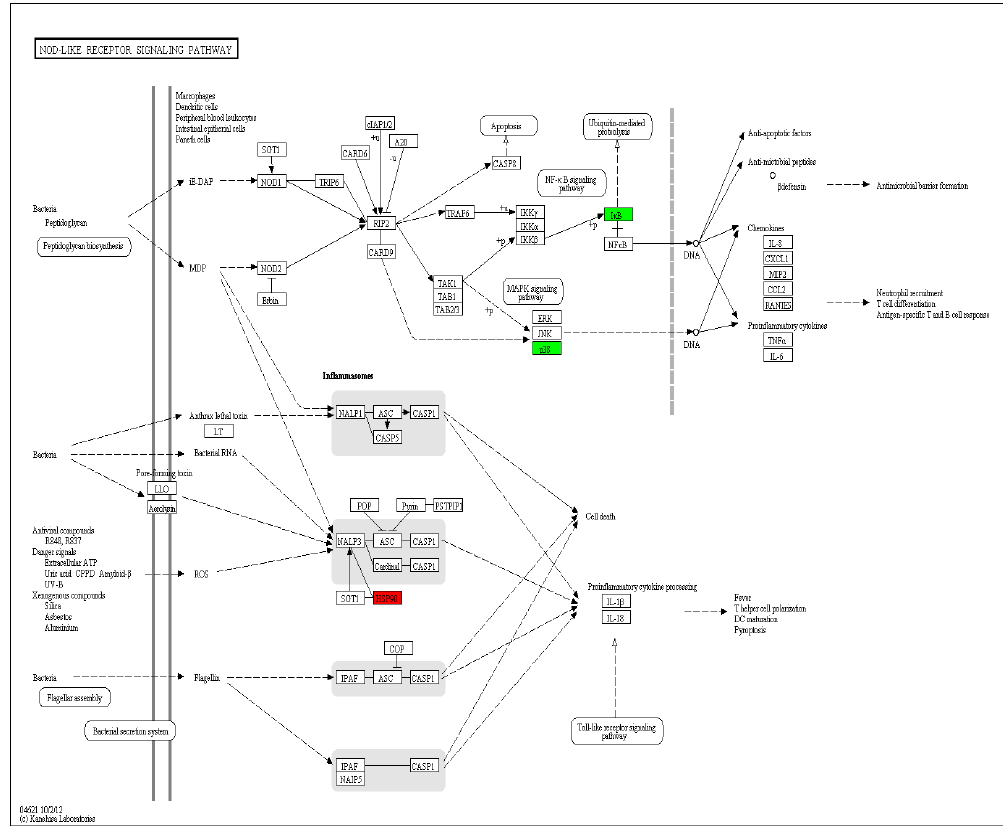
Figure 12. Significantly differentially expressed genes identified by KEGG that are involved in the NOD-like receptor signaling pathway. Red boxes indicate upregulated DEGs; Green boxes represented downregulated DEGs; (For interpretation of colors used in this figure, please refer to the web version of this article).